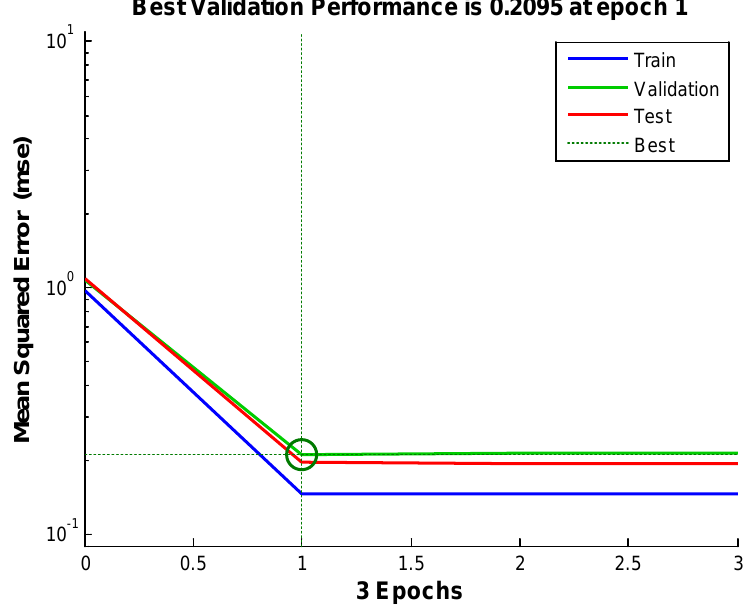
Table 2. Neural network-based data assimilation results.